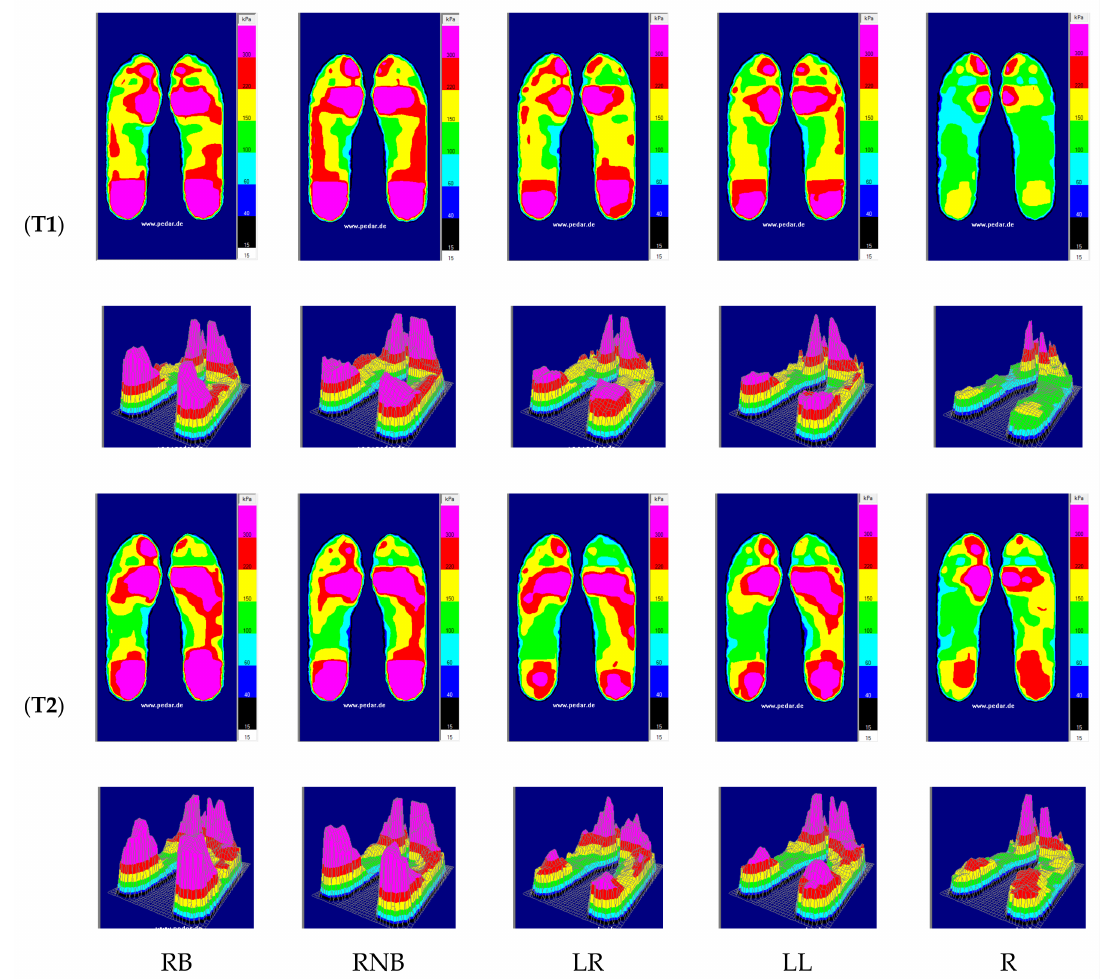
Figure 4. Examples of plantar pressure distributions: comparison between the two assessment times, T1 (November) and T2